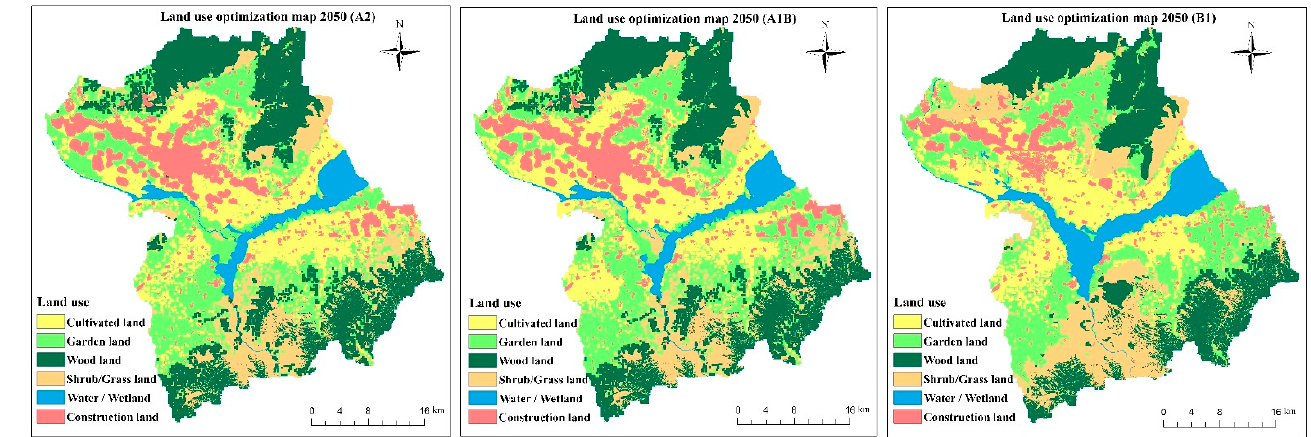
Figure 5. Land use optimization map of Huailai County under future climate change scenarios.